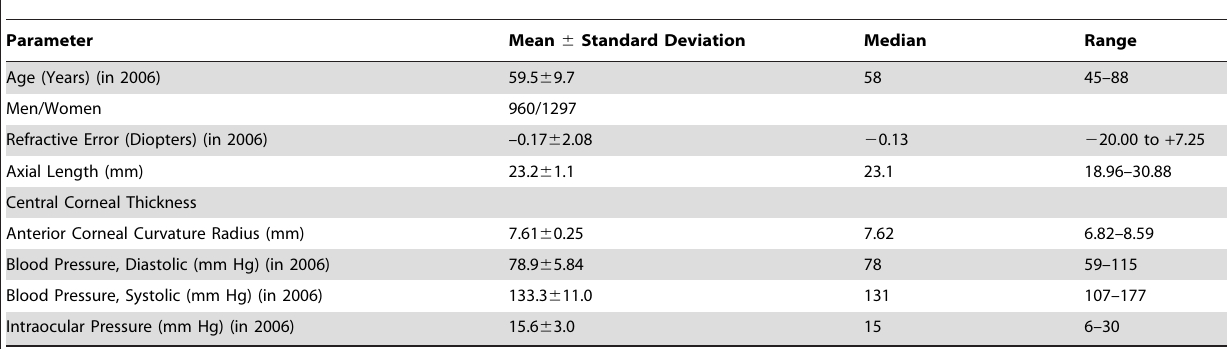
Table 1. Demographic characteristics of the study population.